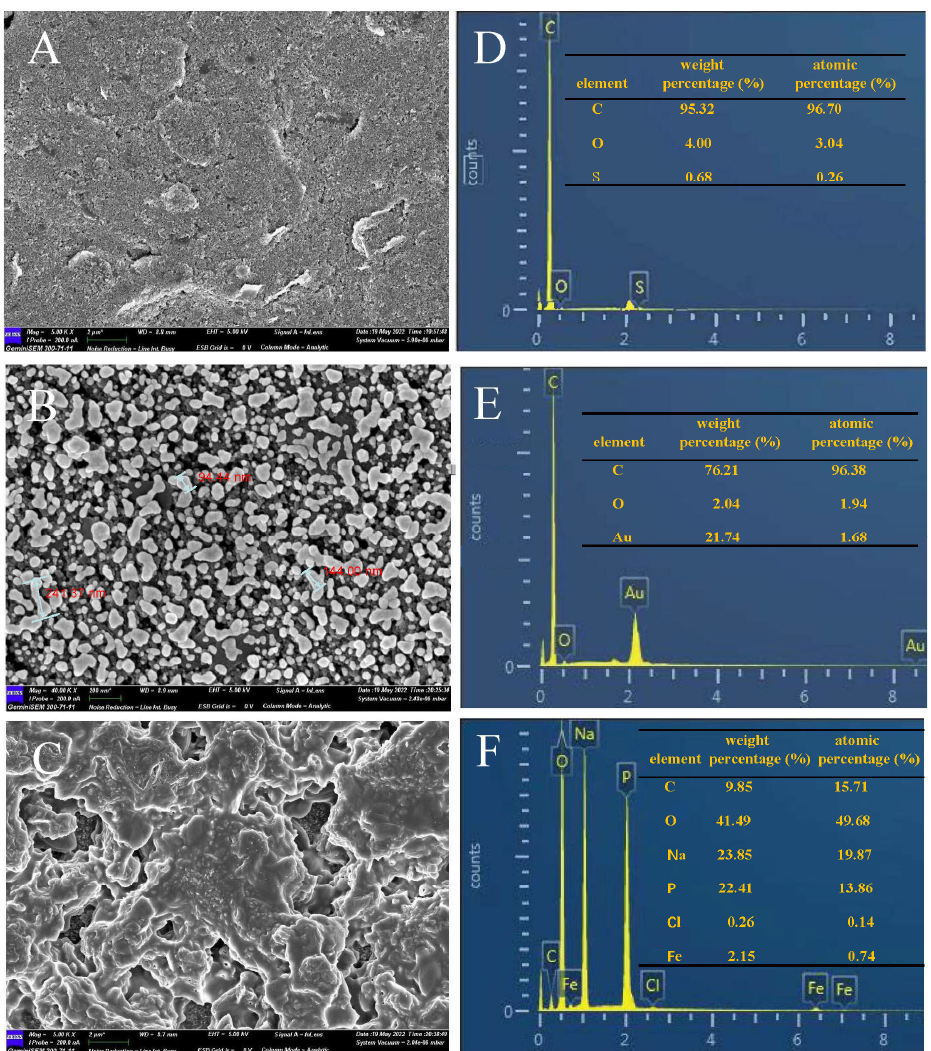
Figure 2. Typical SEM and EDS images of different modified electrodes. ( A , D ): SPCE; ( B , E ): AuNPs/GCE; ( C , F ): Fc(COOH) 2 /AuNPs/SPCE.